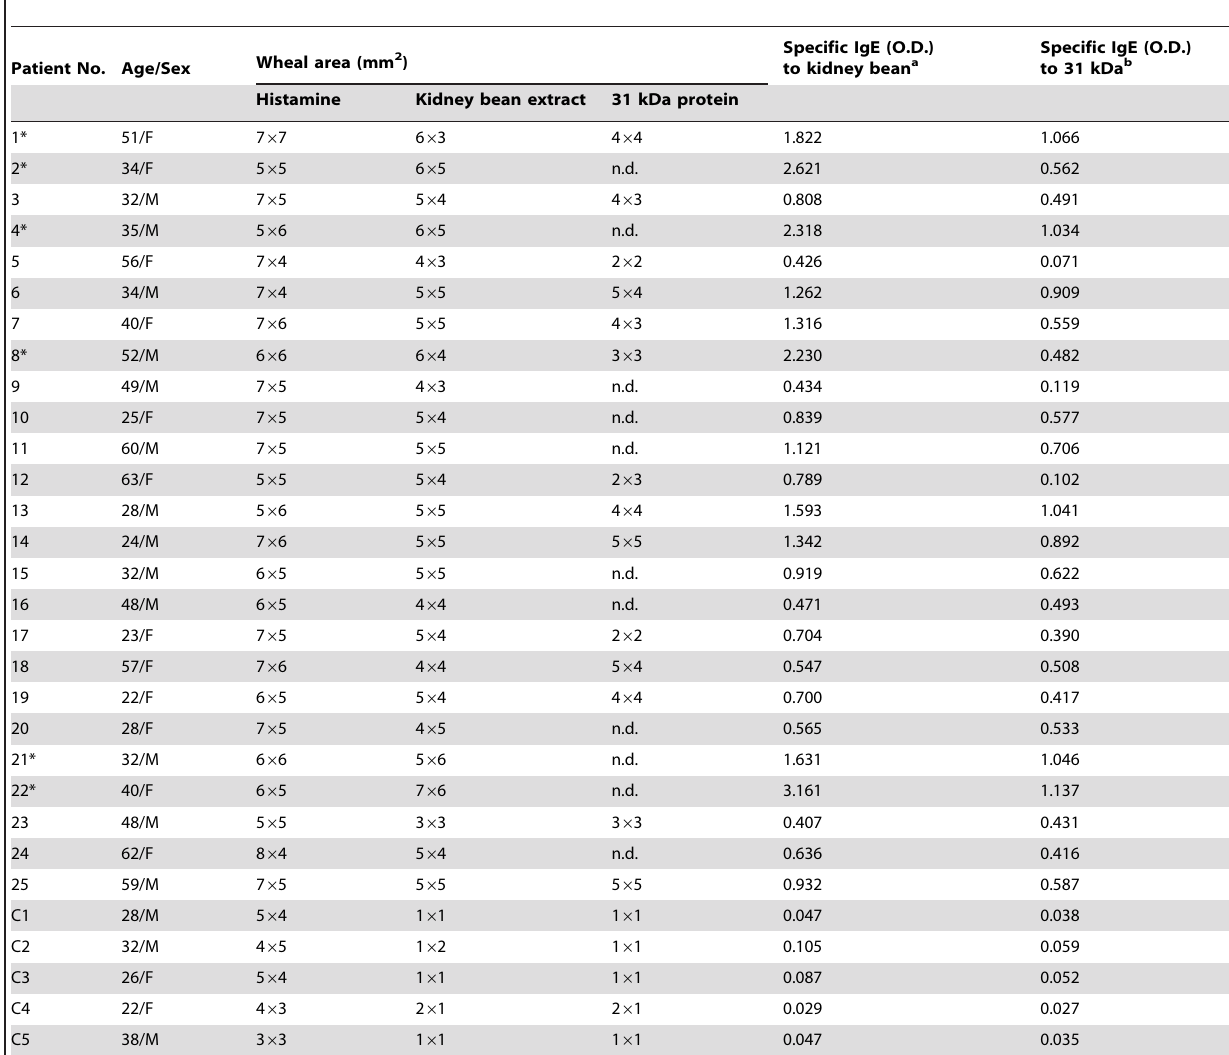
Table 1. SPT and specific IgE among the patients (1 2 25) and controls (C1 2 C5) against raw kidney bean extract and 31 kDa protein.